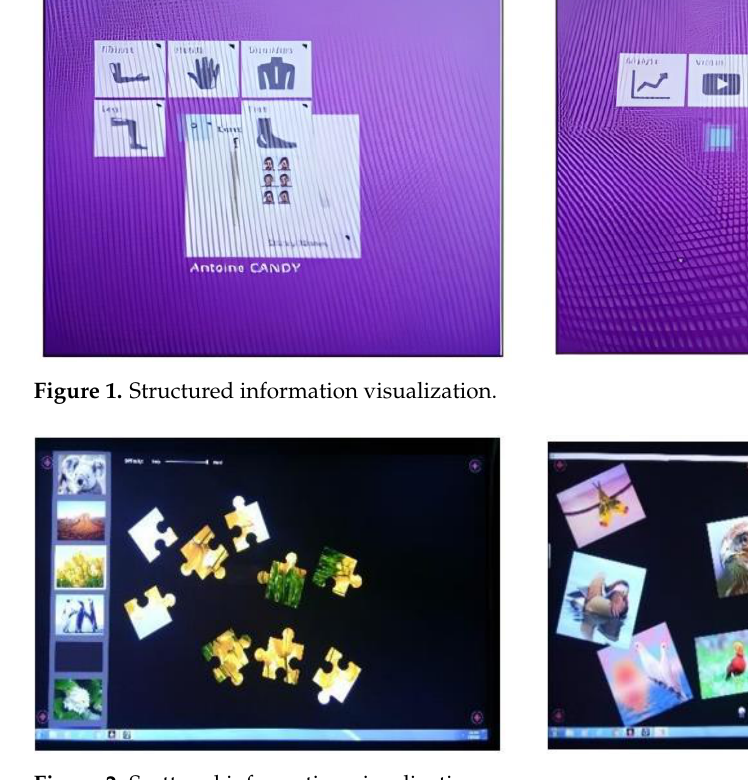
Figure 2. Scattered information visualization.